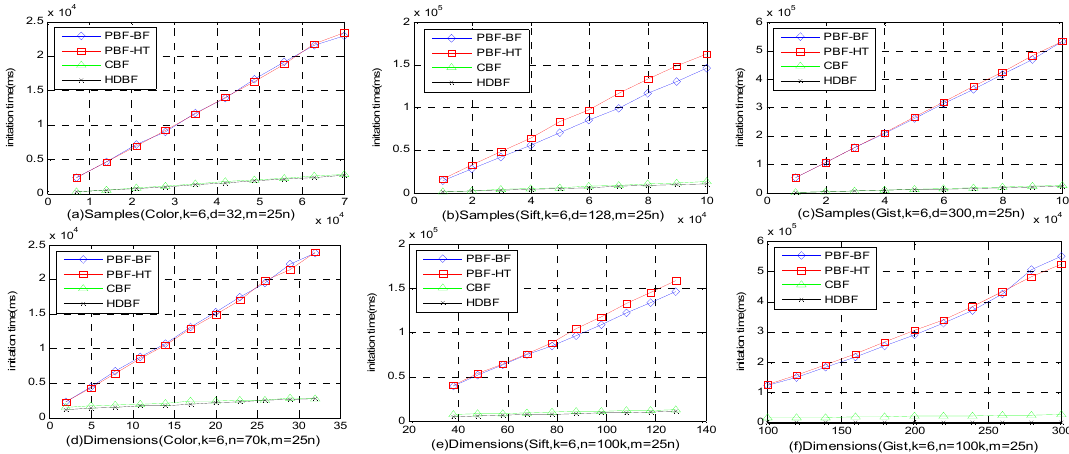
Figure 9. Average initiation time of the PBF-HT, PBF-BF, CBF and HDBF with FPP ⊂ [ 0.0001 − 0.0005 ] ,